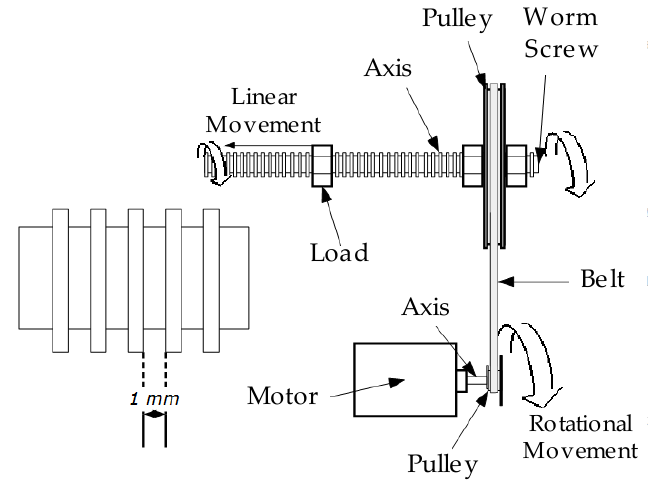
Figure 3. Belt drive system coupled to worm screw.